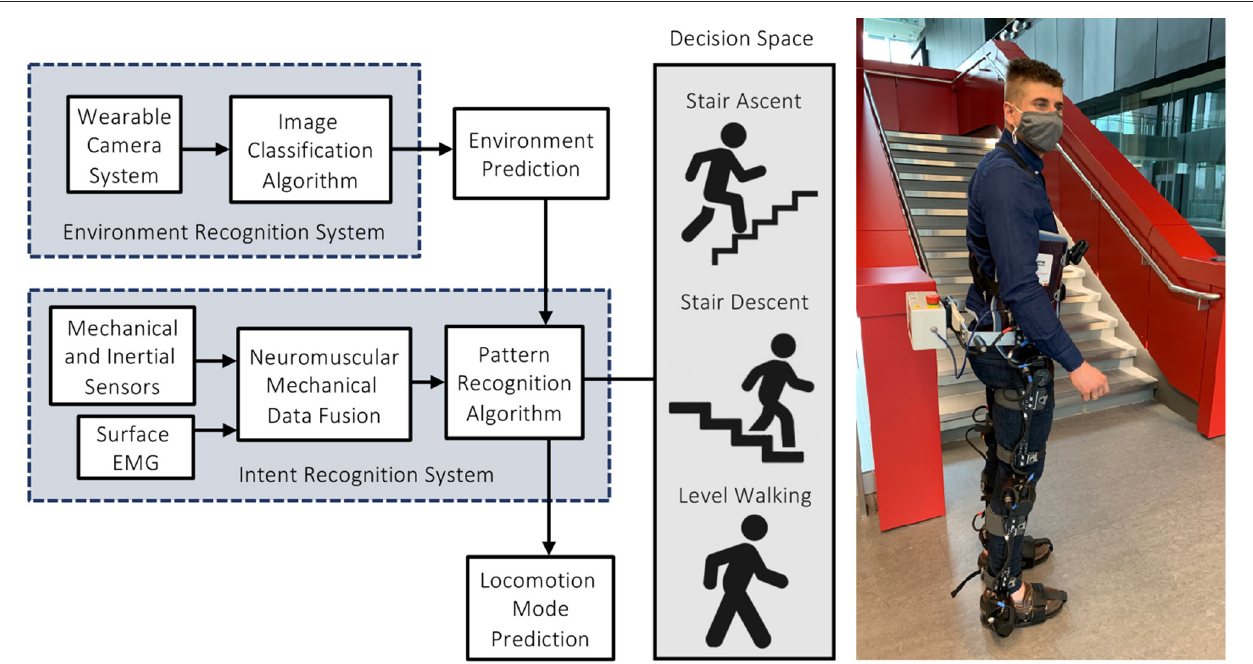
FIGURE 2 | An automated locomotion mode recognition system for robotic leg prostheses and exoskeletons, also known as an intent recognition system or intelligent high-level controller. These systems can be supplemented with an environment recognition system to predict the oncoming walking environments prior to physical interaction, therein minimizing the high-level decision space. The photograph (right) is the lead author wearing our robotic exoskeleton.